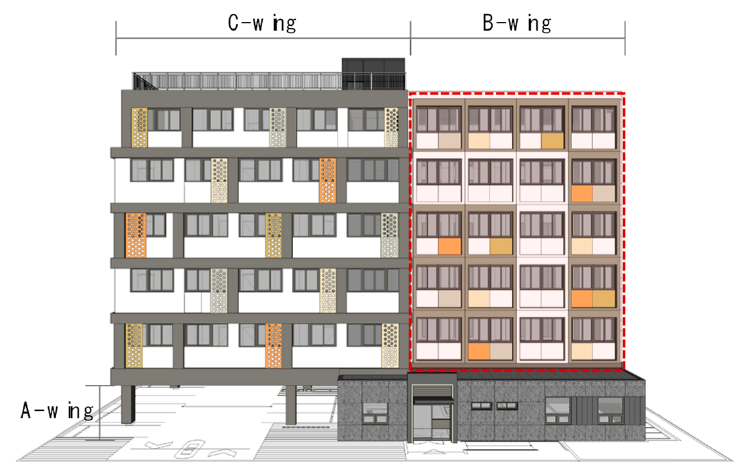
Figure 3. Front view of target building.